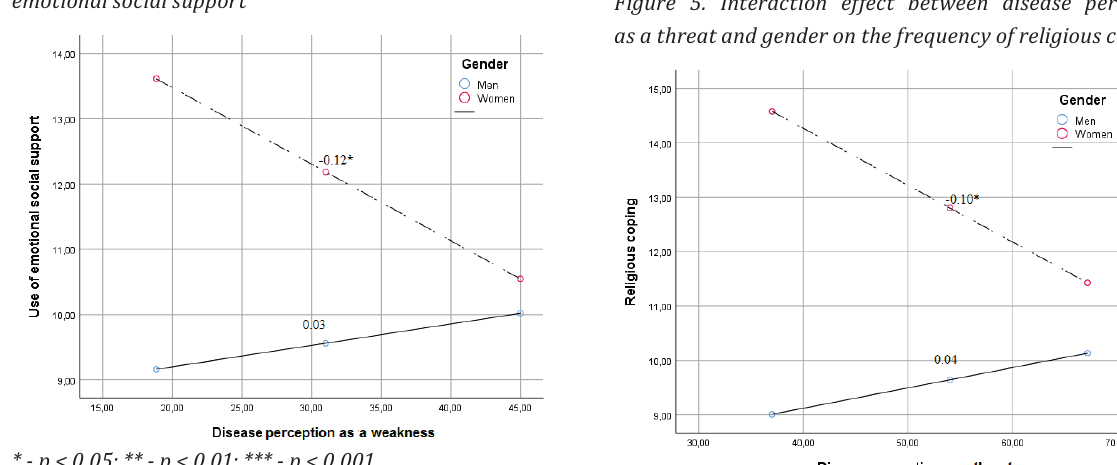
Figure 3. Interaction effect between disease perception as a weakness and gender on the frequency of using of emotional social support